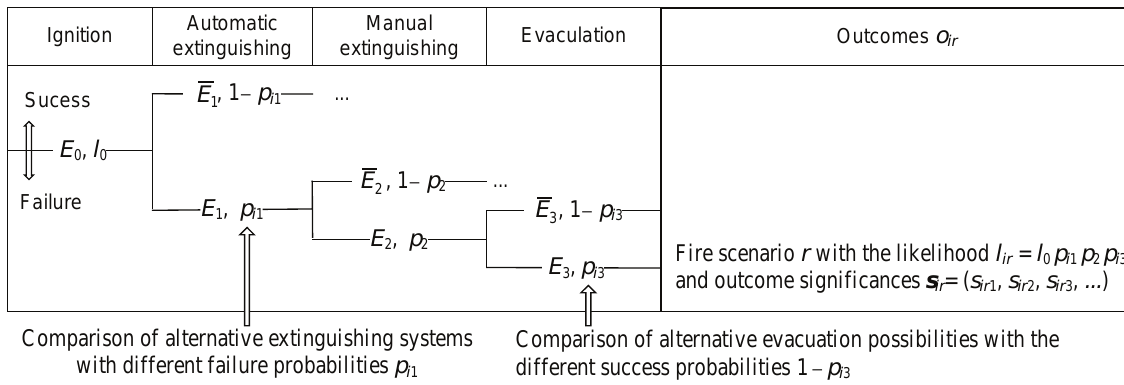
figure 1. A fragment of an event tree diagram with the event tree path expressing the fire scenario r ; the diagram shows also potential points of consideration of alternative fire design solutions within a QRA